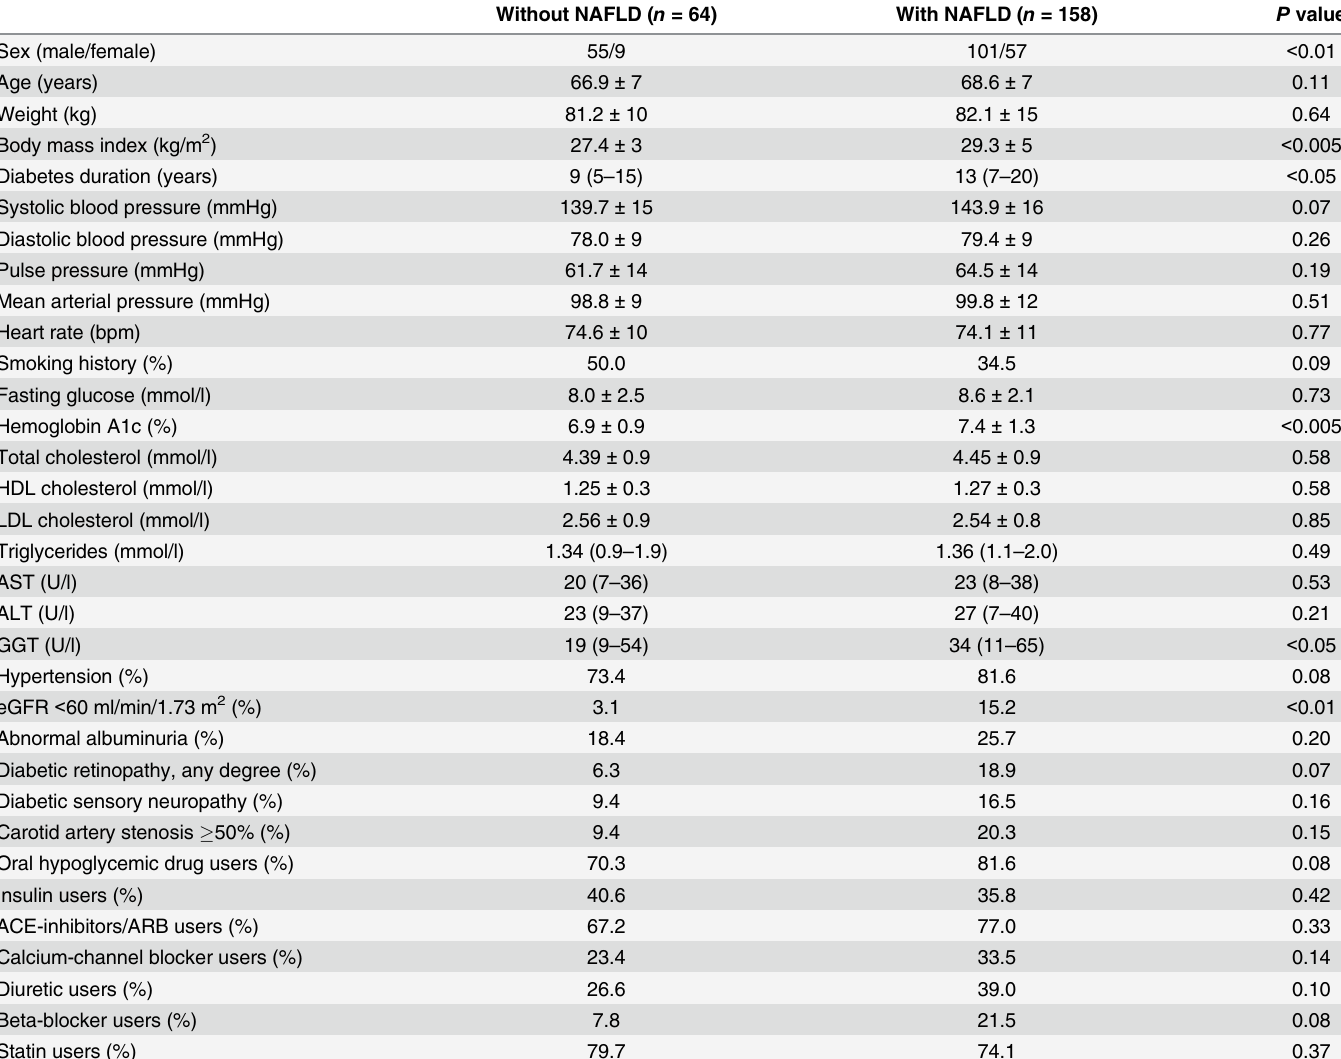
Table 1. Clinical and biochemical characteristics of patients with type 2 diabetes stratified by presence or absence of NAFLD. Without NAFLD ( n = 64) With NAFLD ( n =